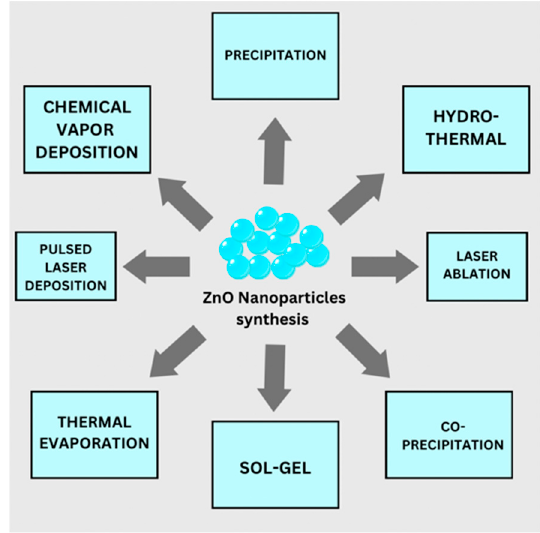
Figure 2. Synthesis methods for ZnO.